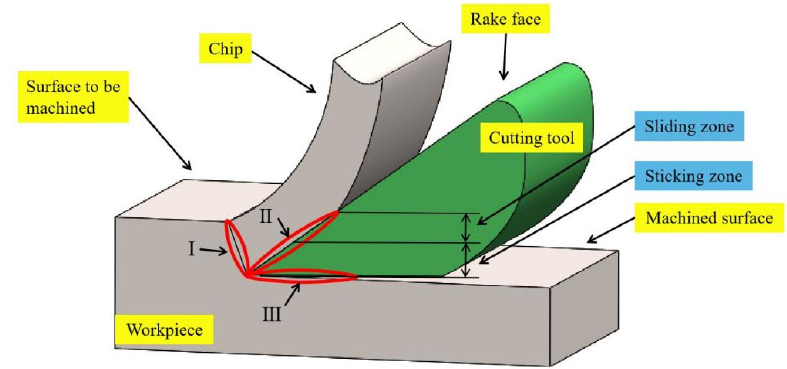
Figure 17. Sticking zone and sliding zone in the rake face. (I) First Slip Zone, (II) Second Slip Zone, (III) Third Slip